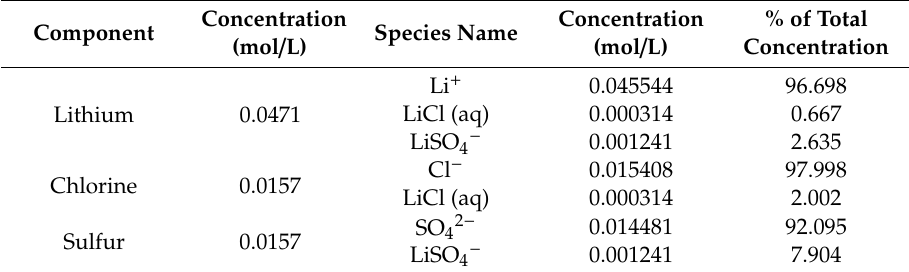
Table 6. Concentrations of ion species in lithium–containing solution with Cl − and SO 42 −